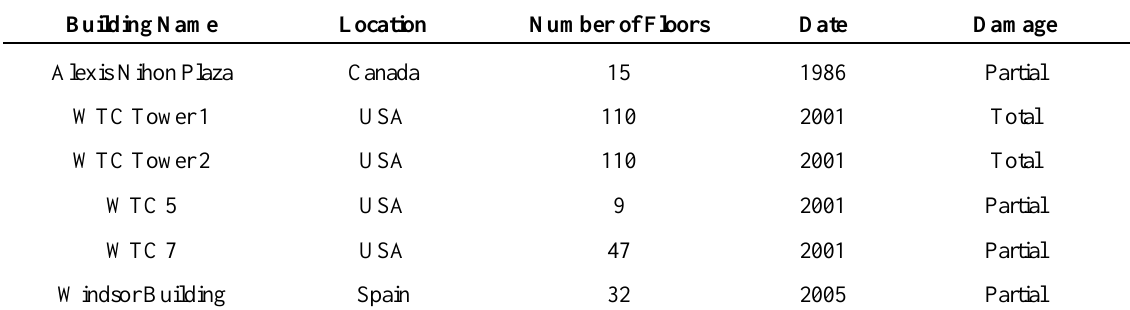
Table 1. Major fire disaster that lead to partial or total collapse (FEMA 403, 2002; NIST,